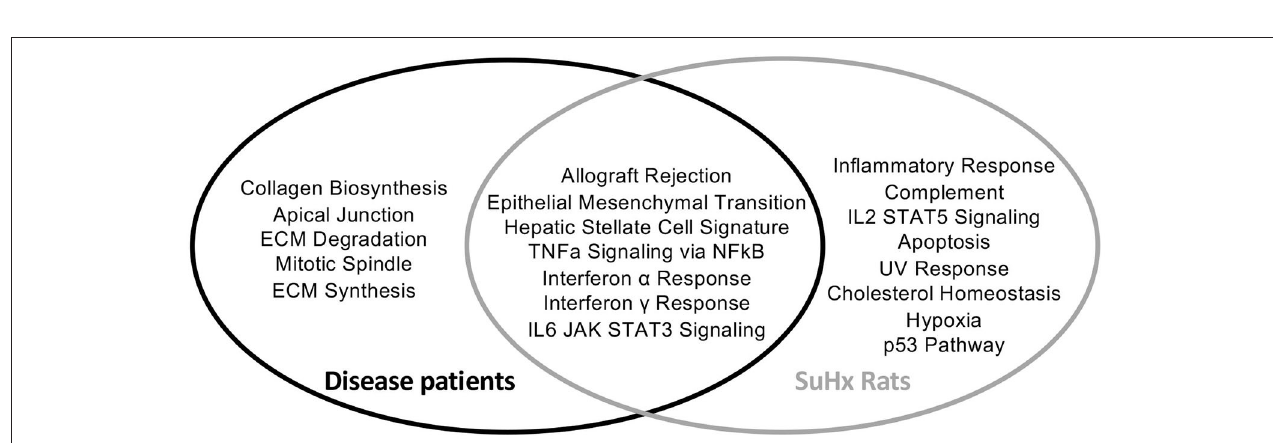
FIGURE 7 | mRAP but not mPAP of patients with hepatic congestion and underlying heart/lung disease shows significant correlation with fibrogenic gene pathways. (A) Two-tailed Spearman correlation plots of mean pulmonary arterial pressure (mPAP) vs. relative expression of different fibrogenic pathways from Nanostring analysis. (B) Two-tailed Pearson correlation plots of mean right atrial pressure (mRAP) vs. relative expression of different fibrogenic pathways from Nanostring analysis.